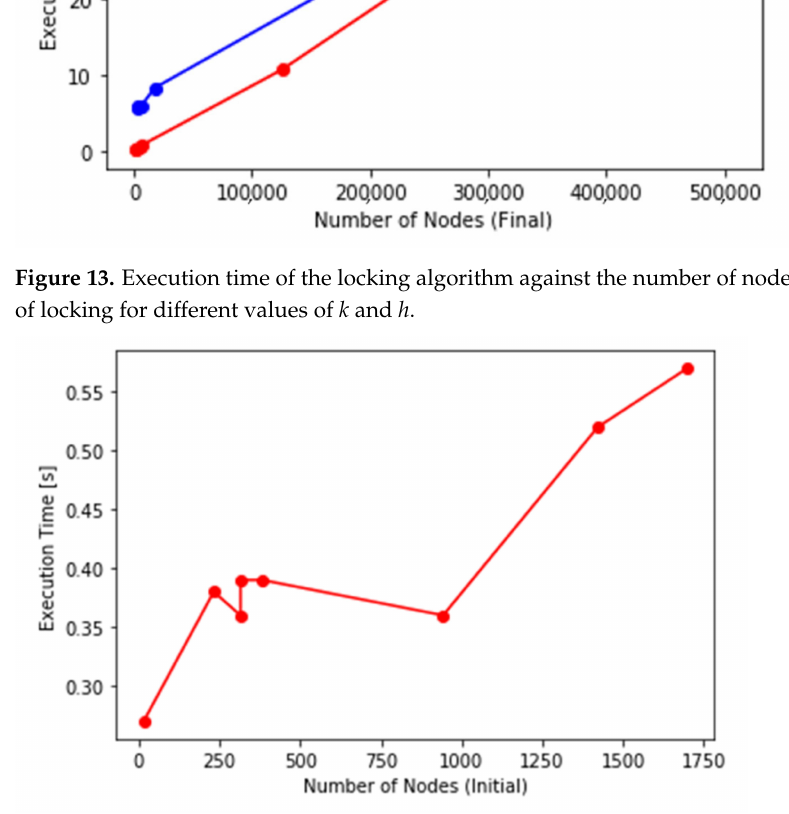
Figure 14. Execution time of the locking algorithm against the number of nodes in the original netlist.